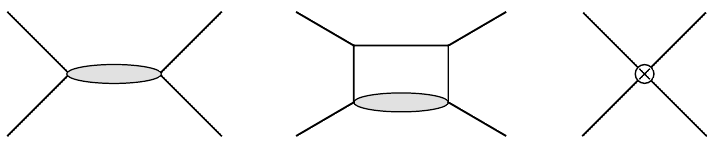
Figure 2 . Contributions to processes involving SM external states: virtual exchange of DS states at tree-level and 1-loop (first two diagrams from the left), contact interaction from UV-generated dim-6 operators (diagram on the right). Solid lines denote SM particles, the gray blob stands for a DS